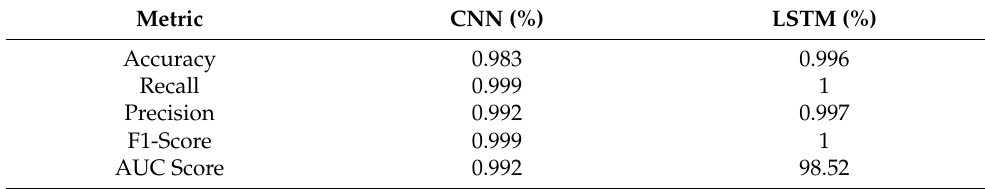
Table 4. Metrics evaluation results of proposed CNN and LSTM